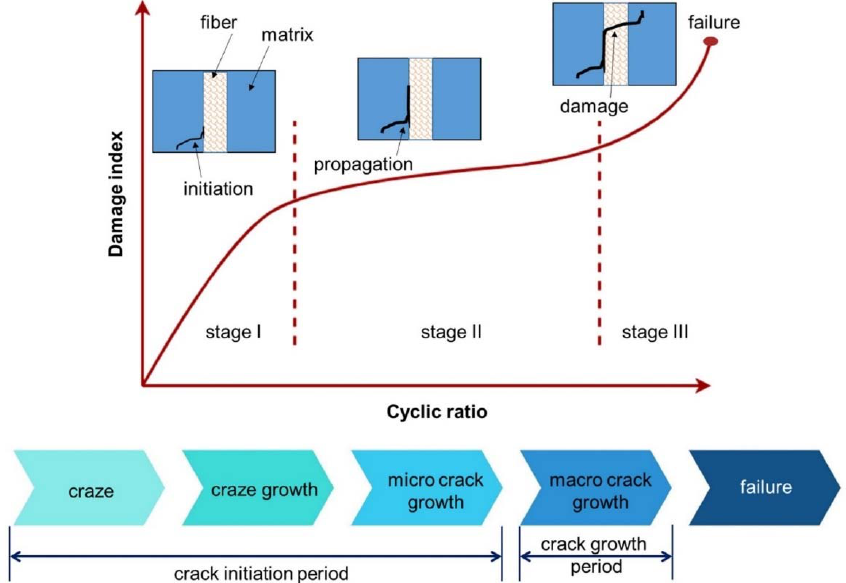
Figure 17. Phases of failure in fiber-polymer composites (available under Creative Commons license [67]).